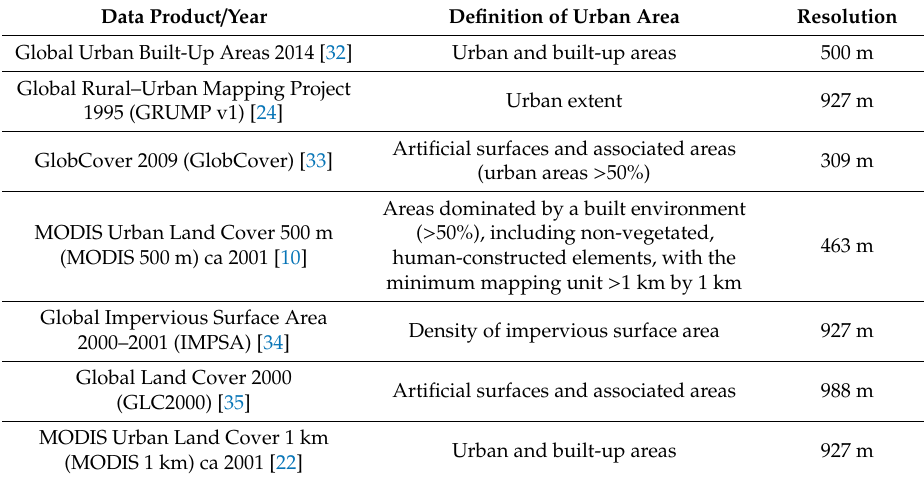
Table 1. Major intermediate-resolution global urban extent or urban extent-related data products derived from satellite imagery available in the past